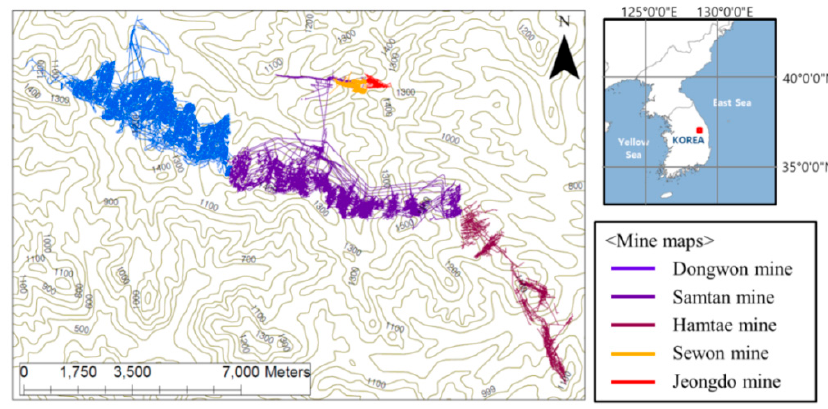
Figure 8. Mine maps of the Dongwon coal mine and surrounding mines. Table 4. The result of correlation coefficients and RMSE between simulated and observed groundwater levels according to pipe parameter of the Dongwon coal mine.